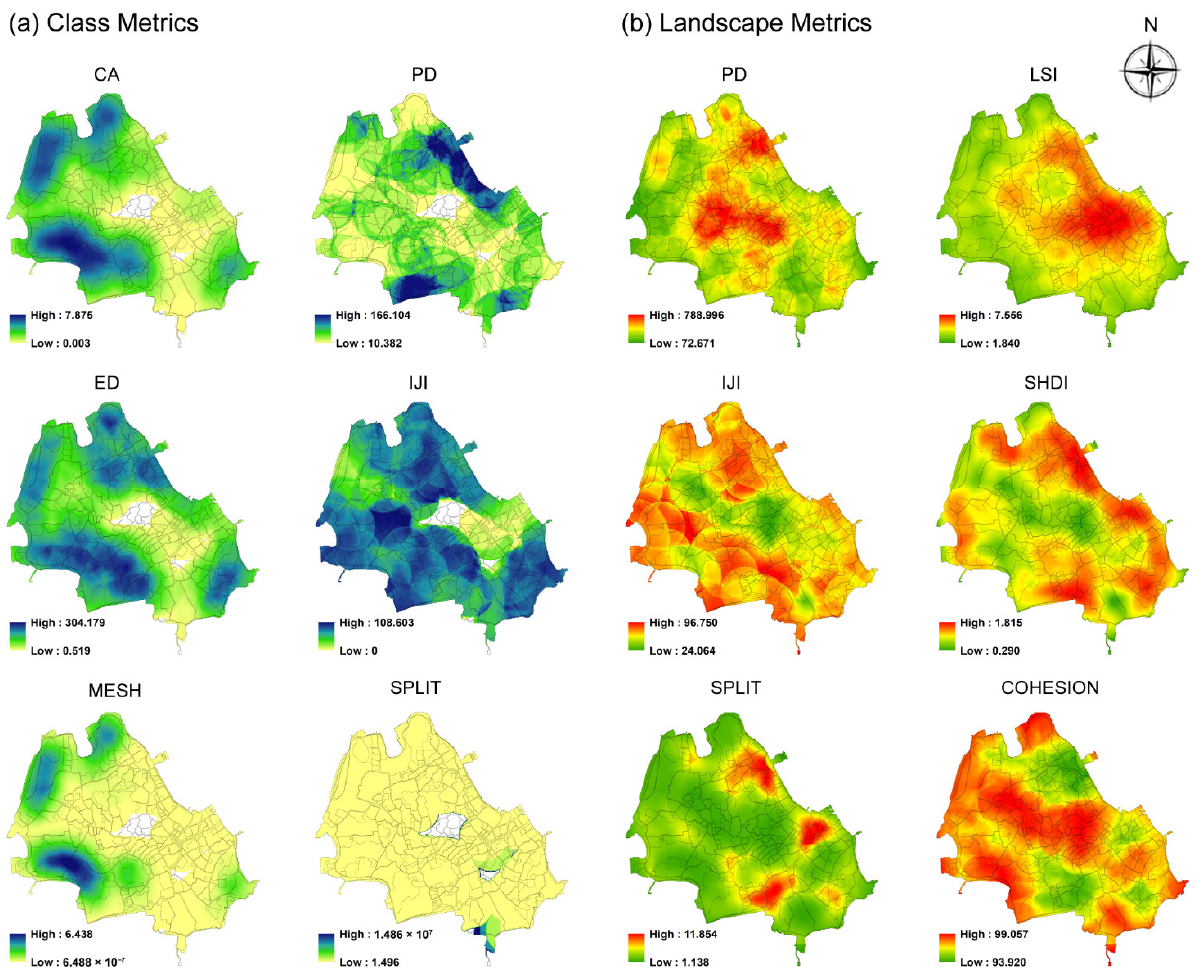
Figure 6. Landscape spatial patterns in ( a ) class metrics and ( b ) landscape